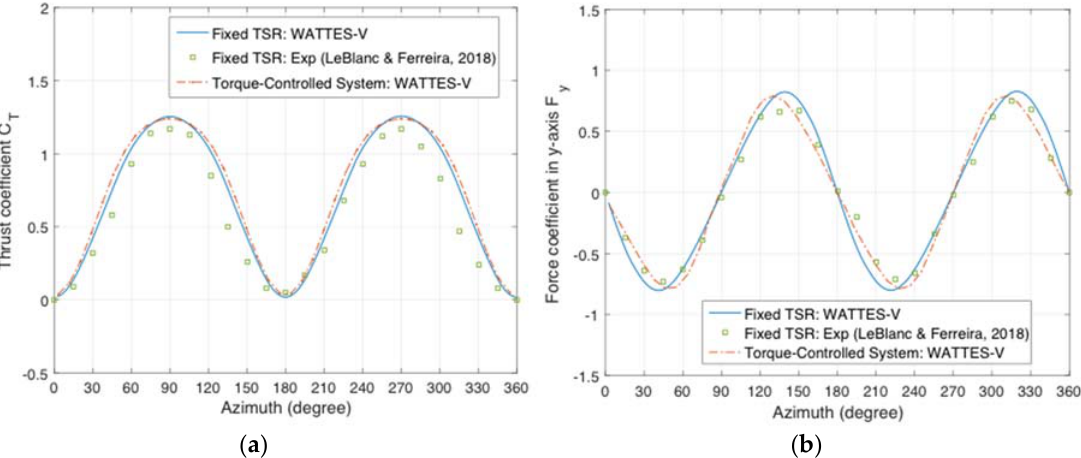
Figure 16. Comparison between predicted (including the model with fixed TSR and the torque-controlled model) and measured [70] thrust and lateral force coe ffi cients for TSR = 3.3 as functions of azimuthal angle: ( a ) thrust coe ffi cient C T ; and ( b ) lateral force coe ffi cient F y .